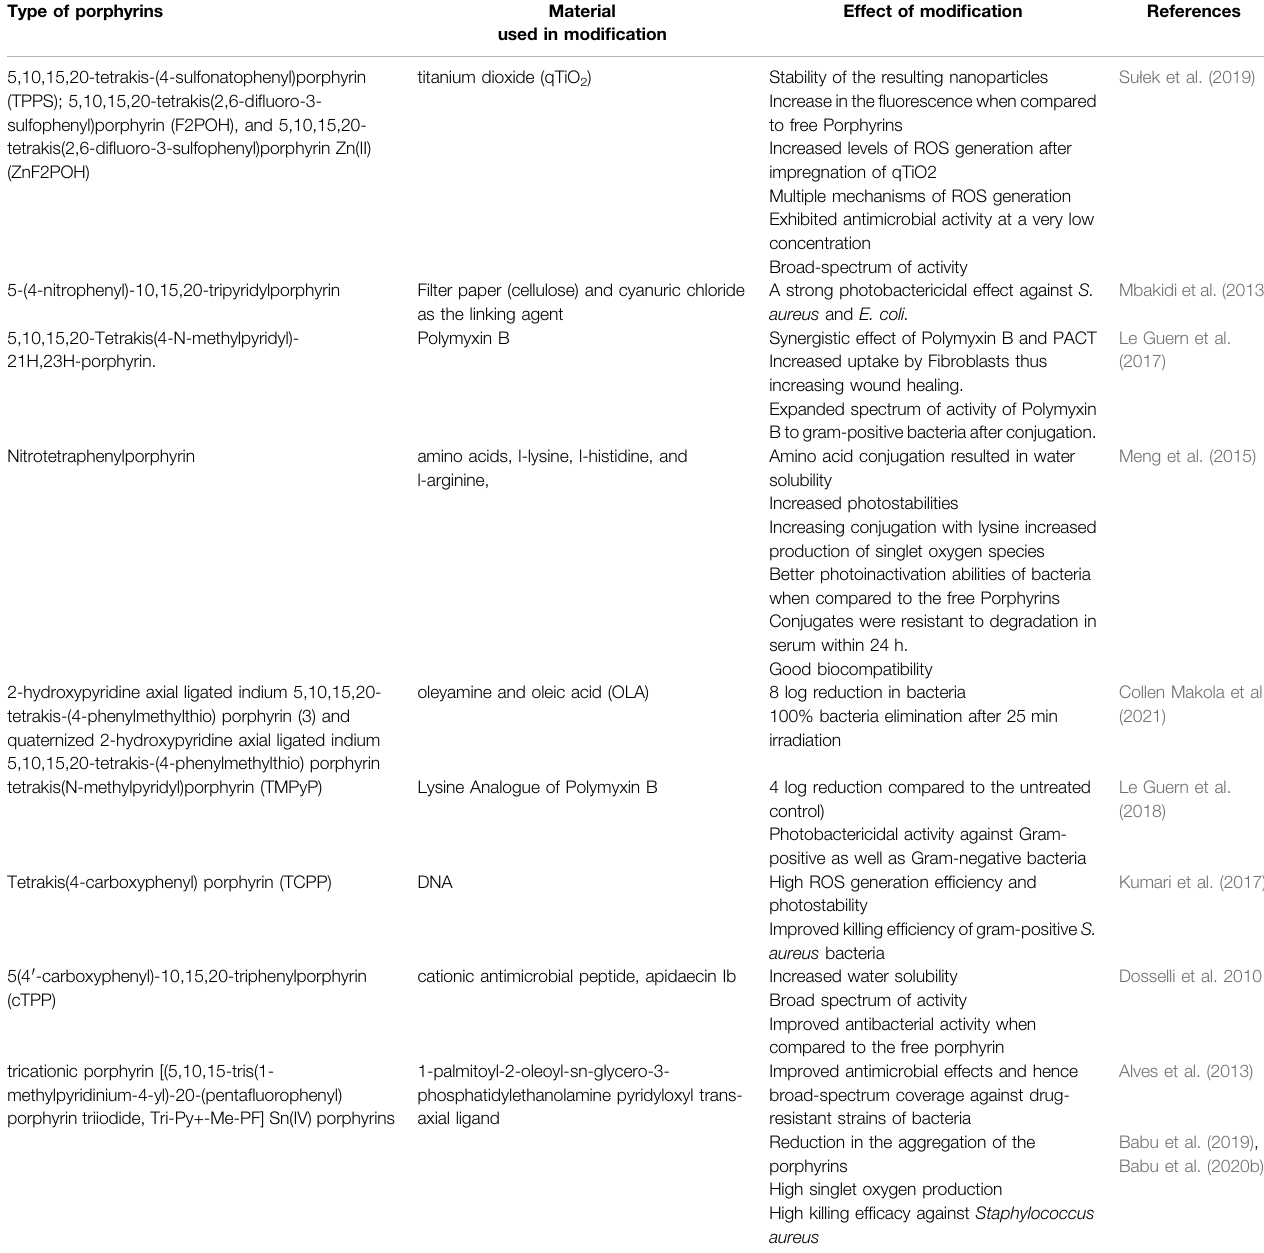
TABLE 1 | Porphyrin fi ne tuning and the resulting conjugate